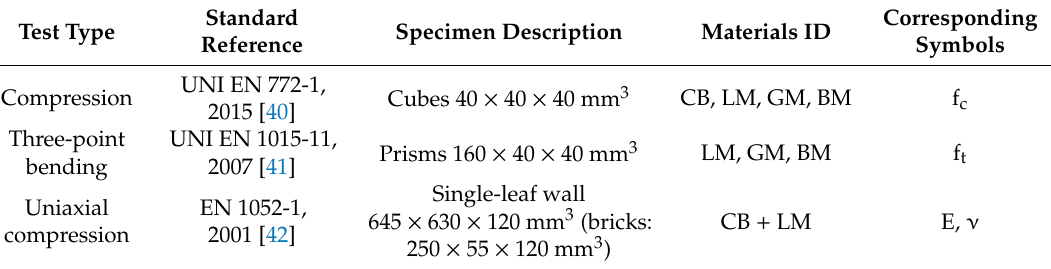
Table 2. Description of the experimental tests for mechanical characterisation of